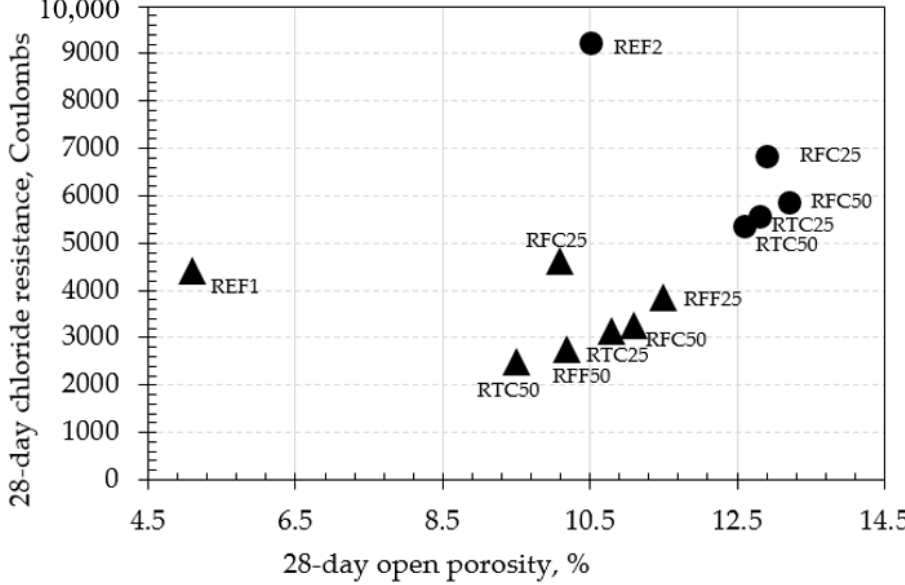
Figure 8. Relationship between open porosity and chloride resistance of concretes at 28 days ( ▲ = w/c ratio 0.25; ● = w/c ratio 0.5).